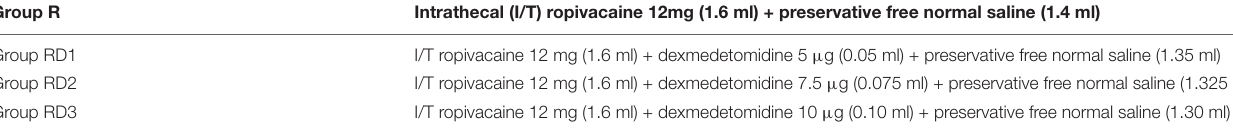
TABLE 1 | Grouping for the study.